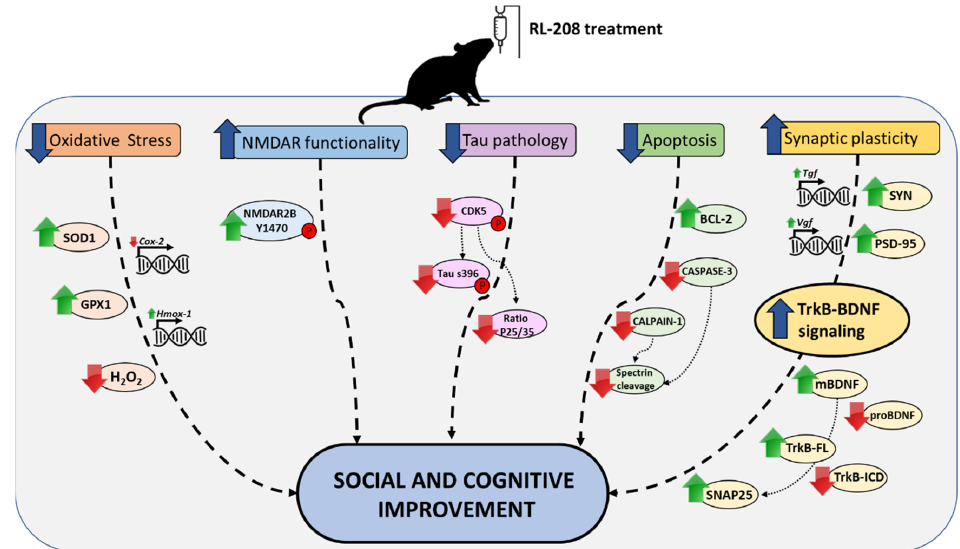
Figure 8. Illustrative cartoon of molecular and cognitive e ff ects after RL-208 treatment. Figure 8. illustrative cartoon of molecular and cognitive effects after RL-208 treatment. Table S1: Antibodies used in Western blot studies, Table S2: Primers used in qPCR studies. Table S3: Parameters Supplementary Materials: The following are available online at www.mdpi.com/xxx/s1, Table S1: Antibodies measured in the Three Chamber. Test Table S4: Parameters measured in the Novel object recognition test (NORT); used in Western blot studies, Table S2: Primers used in qPCR studies. Table S5: Parameters measured in the Object location test